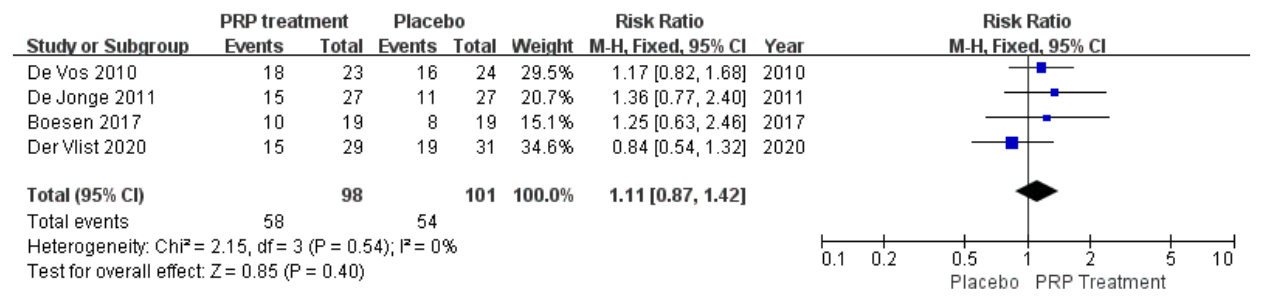
11 of 17 Figure 8. Forest plot of changes in patient satisfaction. Return to Sport A total of 199 patients in four publications correctly and reasonably described the return to exercise rates. There was no statistical heterogeneity between studies (I 2 = 0%, p = 0.54), so a fixed effects model was used to calculate the combined statistic, which showed that the return to exercise rate was higher in the PRP-treated group (experimental group) than in the placebo group (control group) [RR = 1.11, 95% CI (0.87, 1.42), p = 0.40] (Figure 9), a difference that was not statistically significant. This indicates that the PRP treatment group did not show a significantly increased rate of return to exercise relative to the pla- cebo group. Using the Revman 5.4 software to transform the fixed and random effects